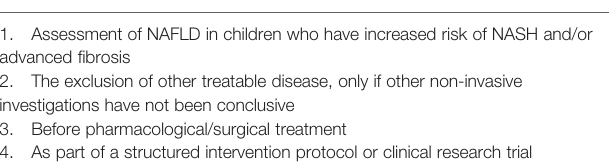
TABLE 2 | Indications for Liver Biopsy of the ESPGHAN Hepatology Committee. Approach to Liver Biopsy in Children and